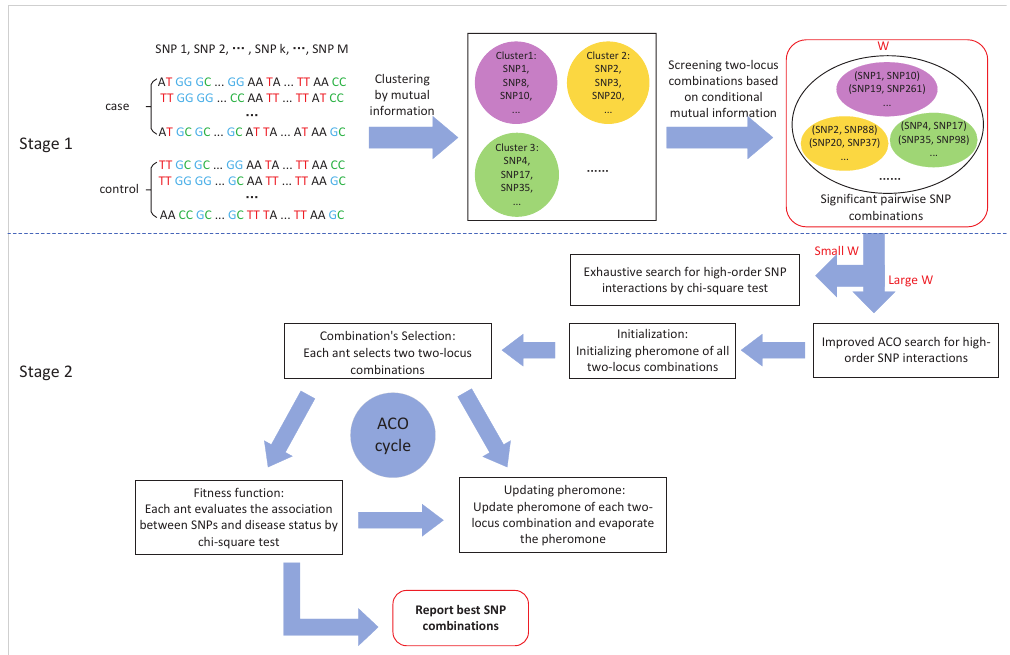
Figure 6. Procedure overview of ClusterMI (Clustering combined with Mutual Information). SNP: single nucleotide polymorphisms; ACO: ant colony optimization